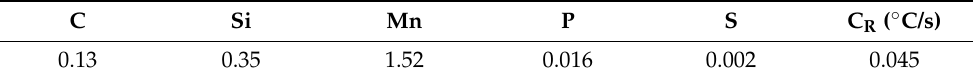
Table 2. Steel compositions and cooling condition for the calculated model.